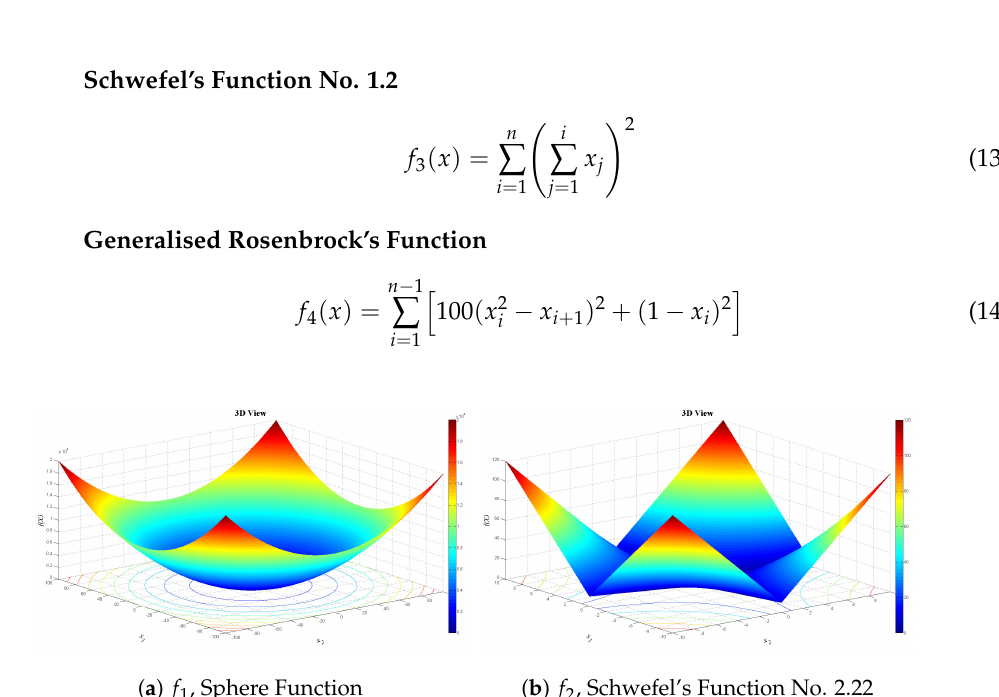
Figure 4. Unimodal benchmark mathematical functions f 1 and f 2 in a 3D view.